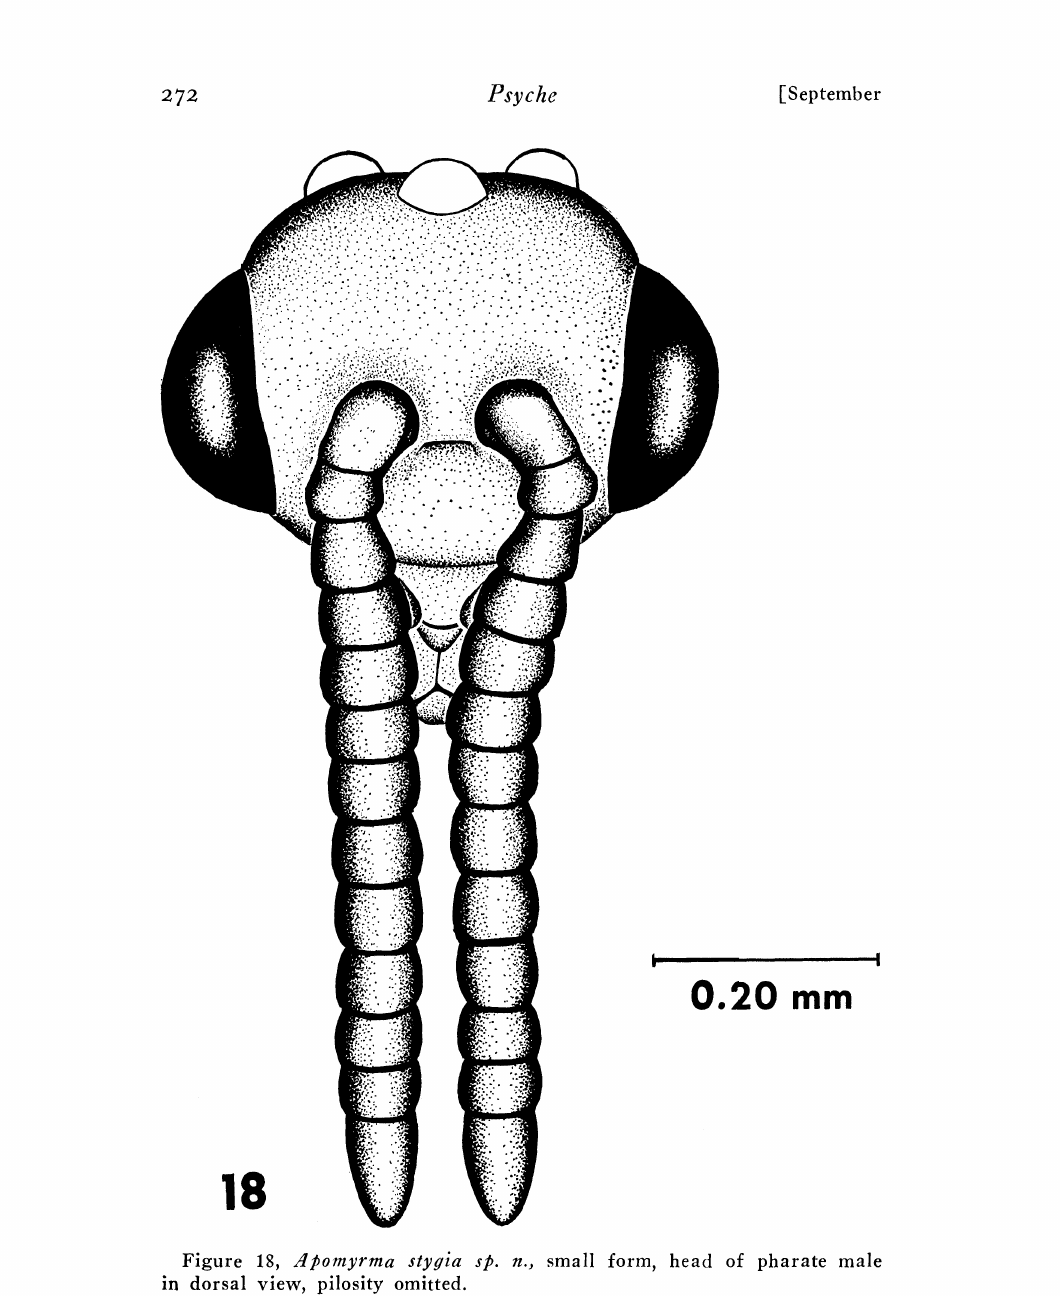
Figure 18, dpomyrma styyia sp. n., small form, head of pharate male in dorsal view, pilosity